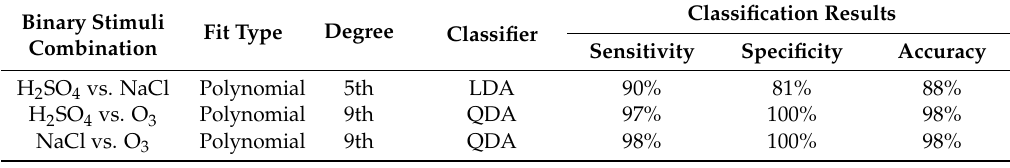
Table 3. Best Binary Classification results (retrospective study) using Curve fit coefficients.